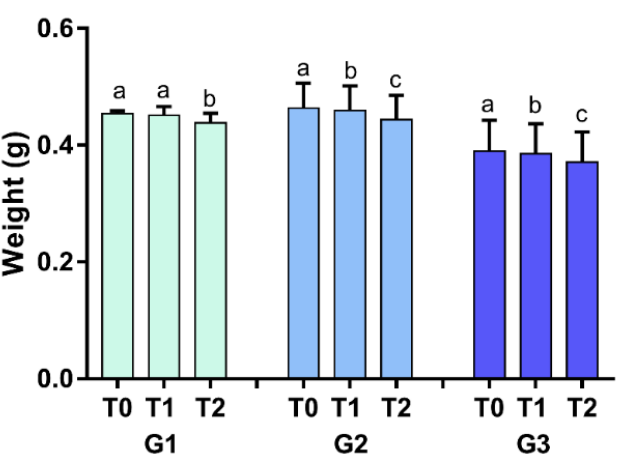
Figure 4. The mean ± standard deviation of the mass variation evaluated by two-way analysis of variance for repeated measures according to the periods for the groups tested. Different lowercase letters indicate an intragroup statistically significant difference.